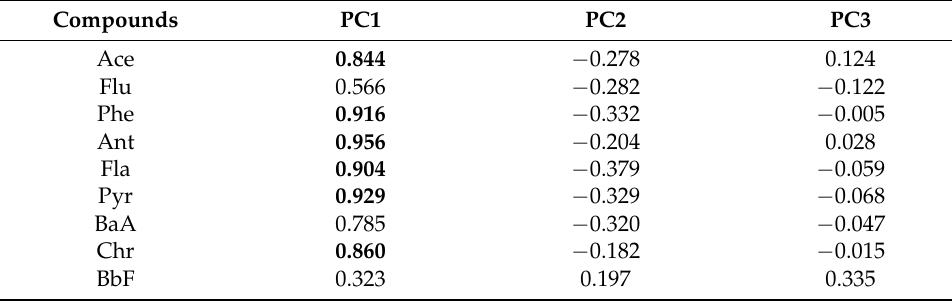
Table 5. Principal component analysis of PAHs in PM 2.5